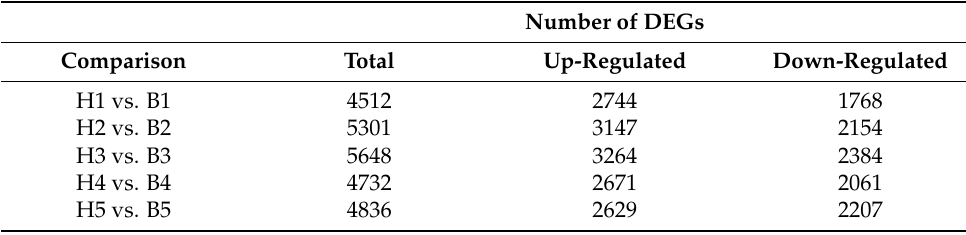
Table 2. Number of DEGs identified in different comparisons between the yellow mutant and ‘Jinzhan